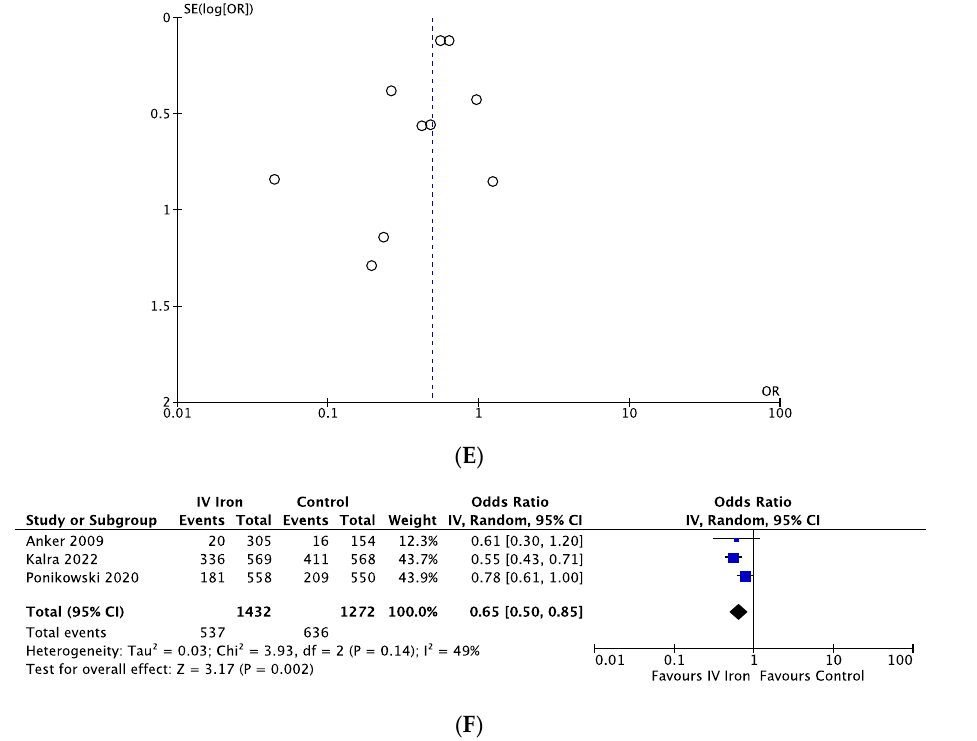
Figure 3. ( A ) Forrest plot for cardiovascular mortality with intravenous iron replacement compared to control using fixed effects model. ( B ) Forrest plot for all-cause mortality comparing both arms using fixed effects model. ( C ) Funnel plot for all-cause mortality. ( D ) Forrest plot for hospitalizations for heart failure with intravenous iron replacement compared to control using random effects model. ( E ) Funnel plot for hospitalizations for heart failure. ( F ) Forrest plot for hospitalizations for heart failure and cardiovascular death using random effects model.